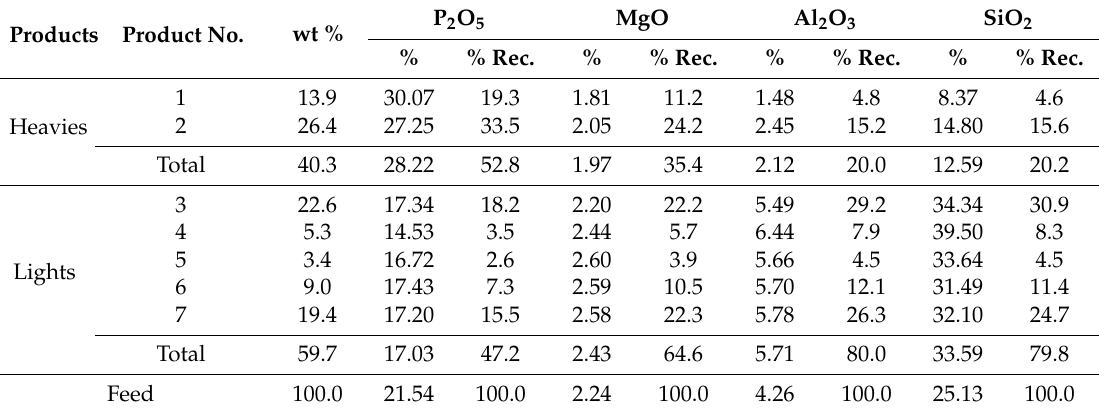
Table 5. Results of the spiral separation (Rec.: recovery).